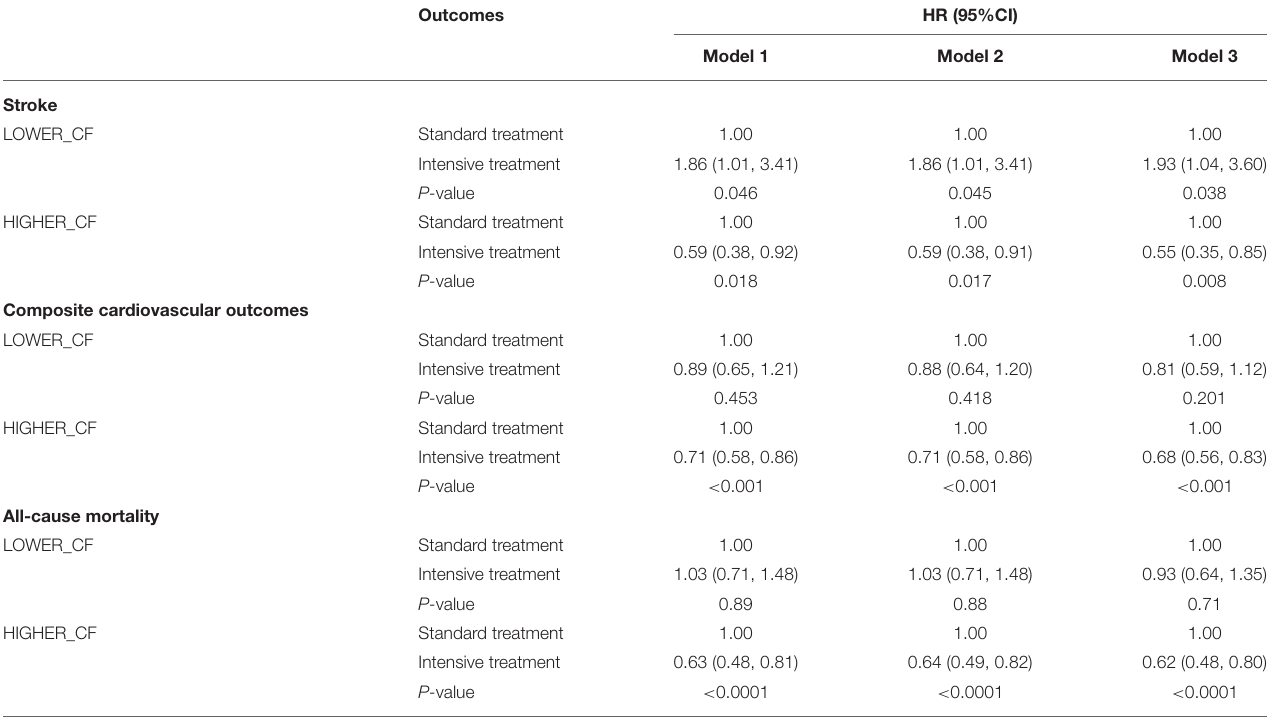
TABLE 2 | Stroke, composite cardiovascular outcomes, and all-cause mortality by the treatment arms and baseline cognitive